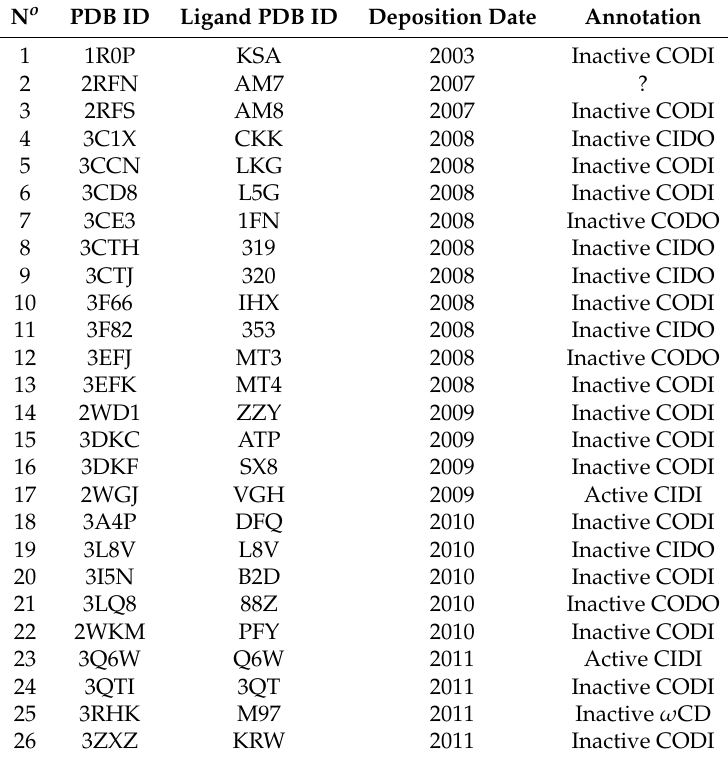
Table 2. List of the 26 PDB MET kinase domain structures selected in the previous work [22] and reused in the present one. The kinase conformation associated to each structure is annotated according to the KinaMetrix web resource [56]: DO means DFG-out, DI means DFG-in, CO means α -cHelix-out, CI means α -cHelix-in, and ω CD indicates DFG intermediate.